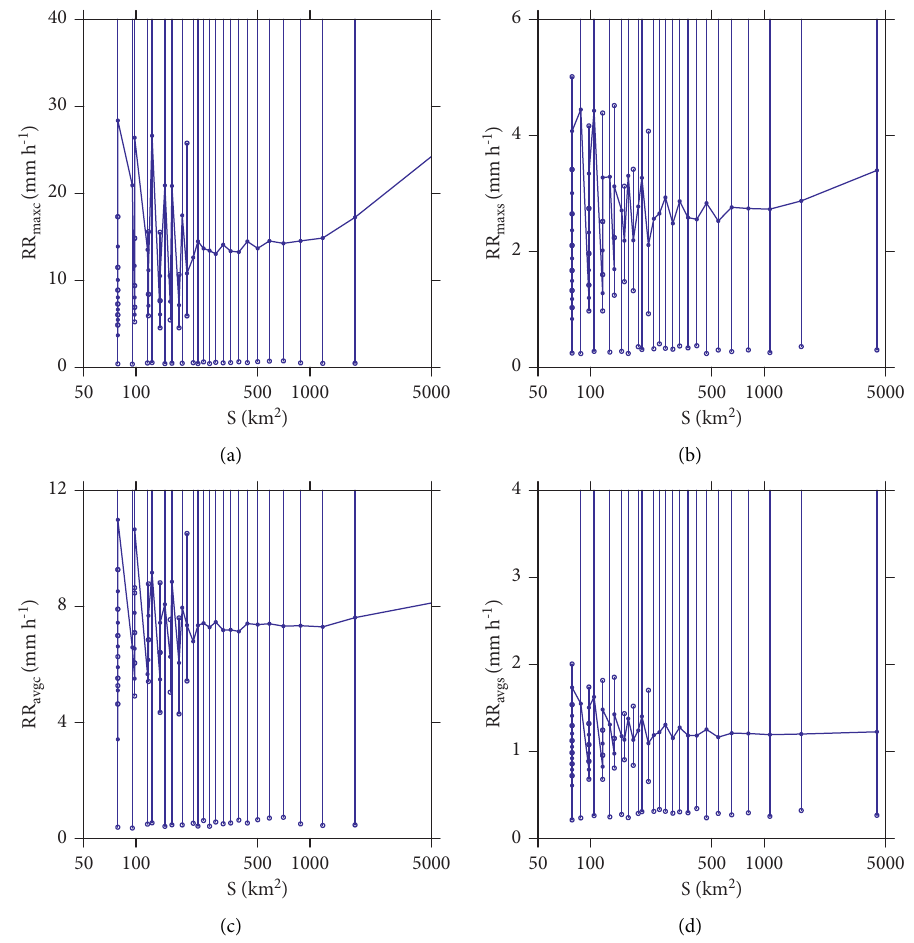
Figure 11: The relationship between RR maxc and S (a), RR maxs and S (b), RR avgc and S (c), and RR avgs and S (d) on Tibetan Plateau from 1998 to 2015 based on the statistical principle of same samples in each interval at x axis.